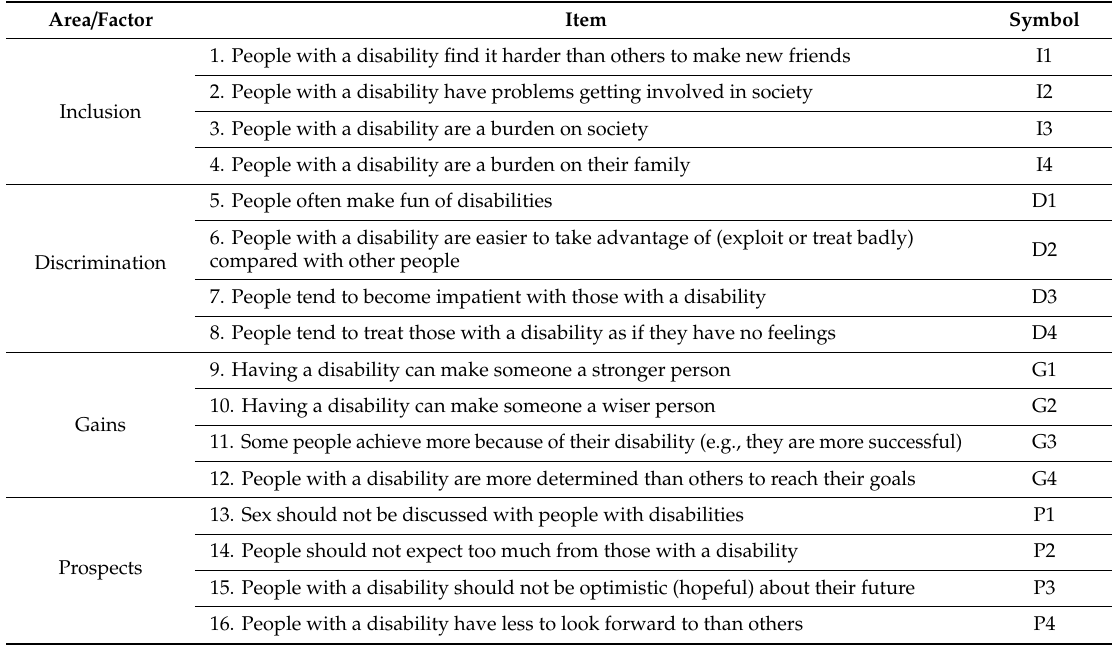
Table 1. Attitudes to Disability Scale (ADS) developed by WHOQOL Group [15].